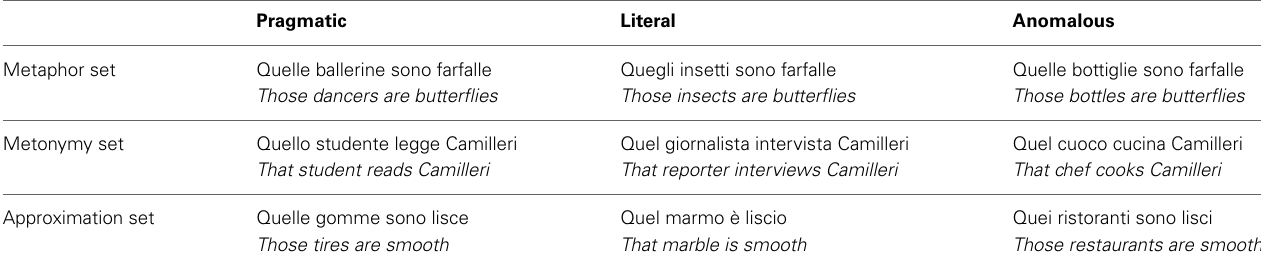
Table 1 | Examples of stimulus triplets for the Metaphor set, the Metonymy set, and the Approximation